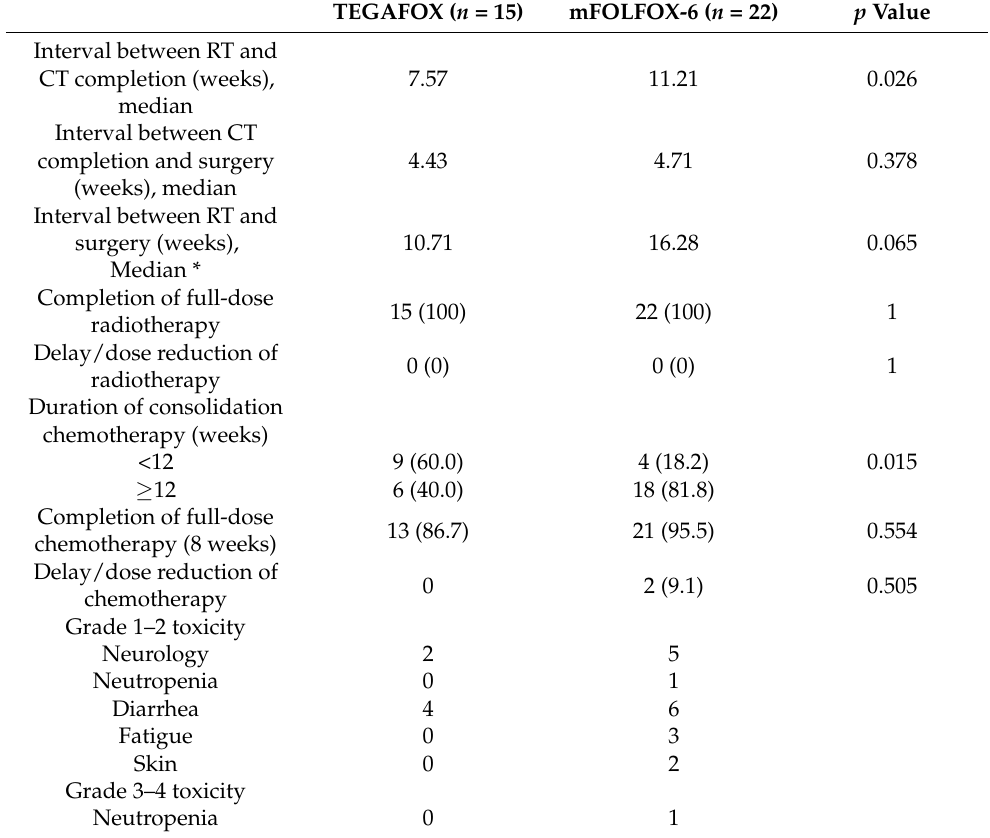
Table 3. Patient compliance and acute toxicity by chemotherapy